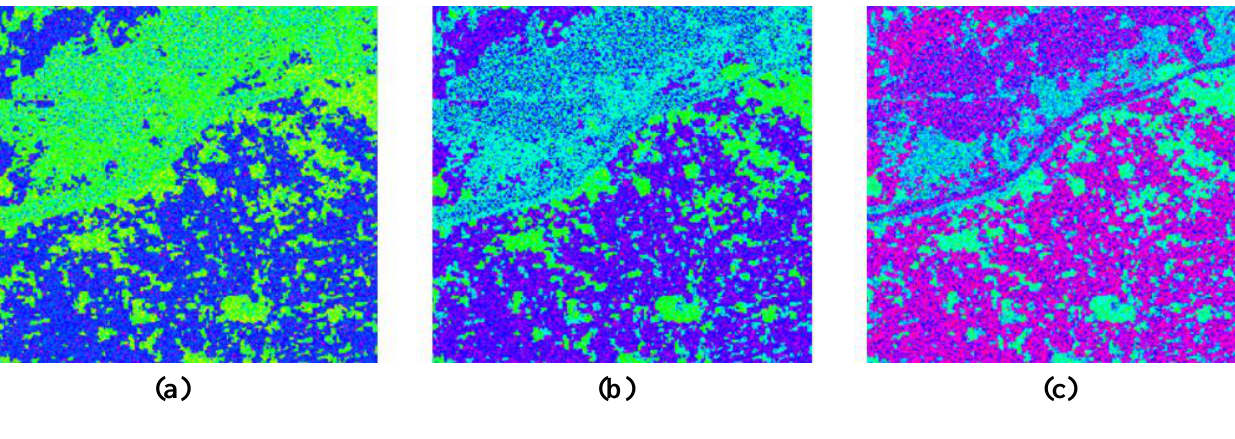
Figure 4. A 200 band hyperspectral image generated from spectral libraries of four different minerals: ( a ) band 1; ( b ) band 100; ( c ) band